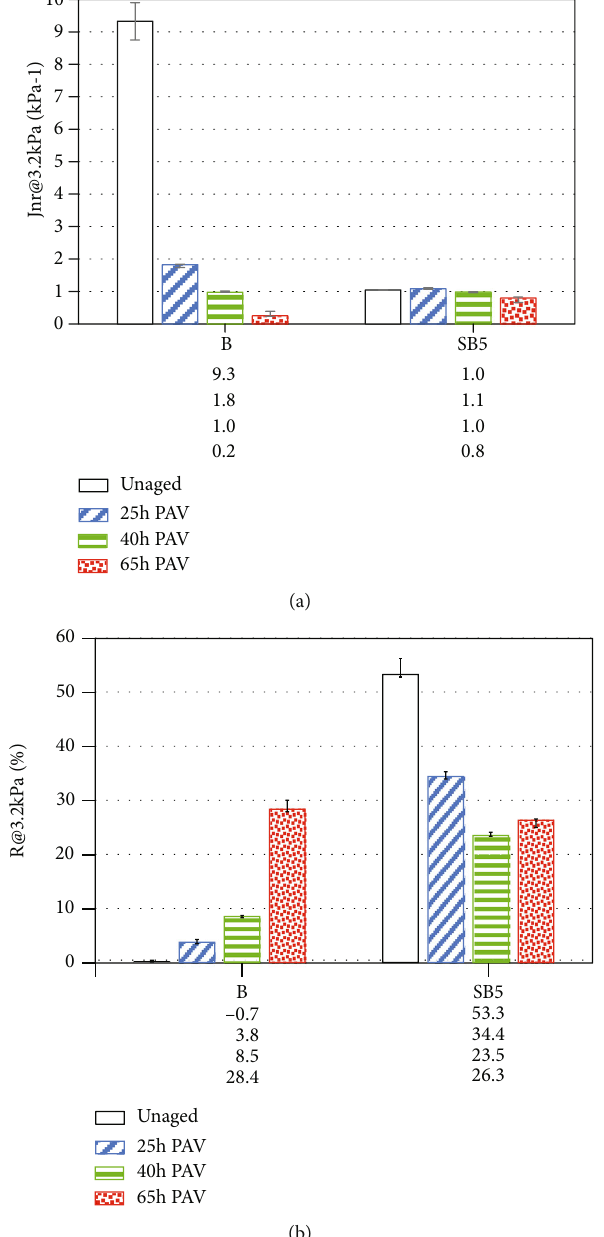
Figure 10: J (a) and R (b) @3.2kPa. AASHTO M 332 tra ffi c designation: S : standard ( J nr max = 1 kPa − 1 ); E: extremely heavy ( J V: very heavy ( J nr